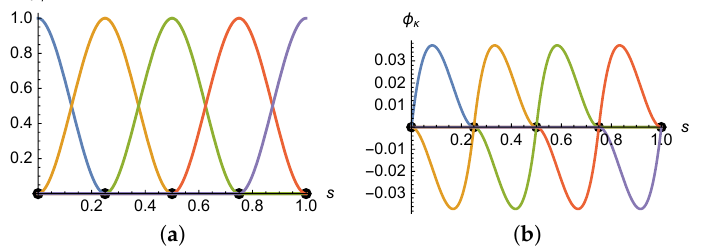
Figure A1. Sets of H 2 finite element basis functions ( a ) φ ψ j and ( b ) ψ κ j , j = 1, . . . ,5.